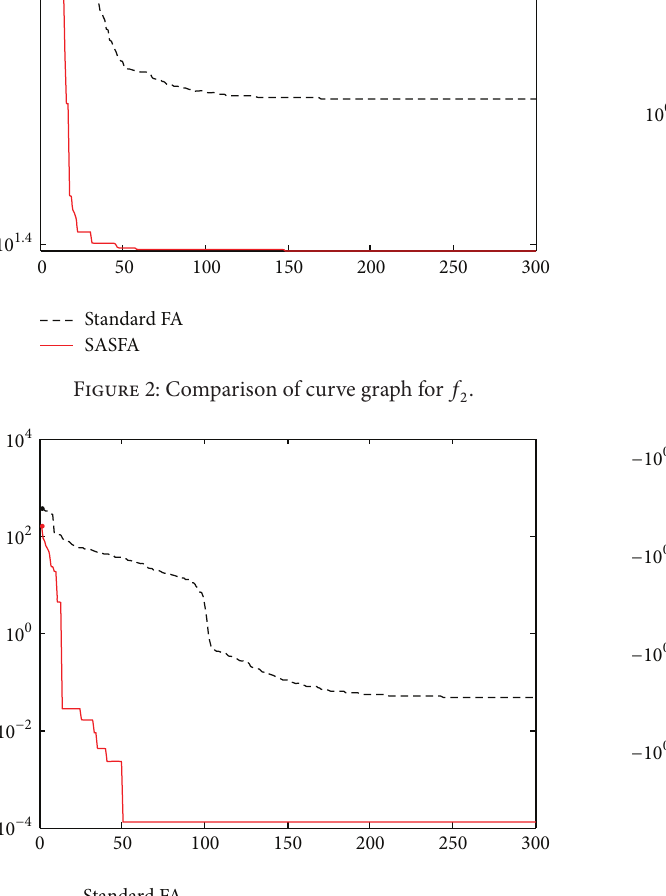
Figure 1: Comparison of curve graph for 𝑓 1 .